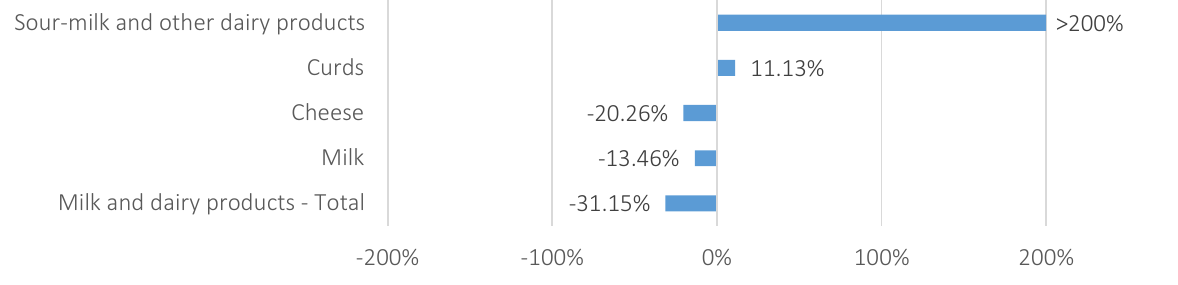
Figure 7. Average consumption for segment